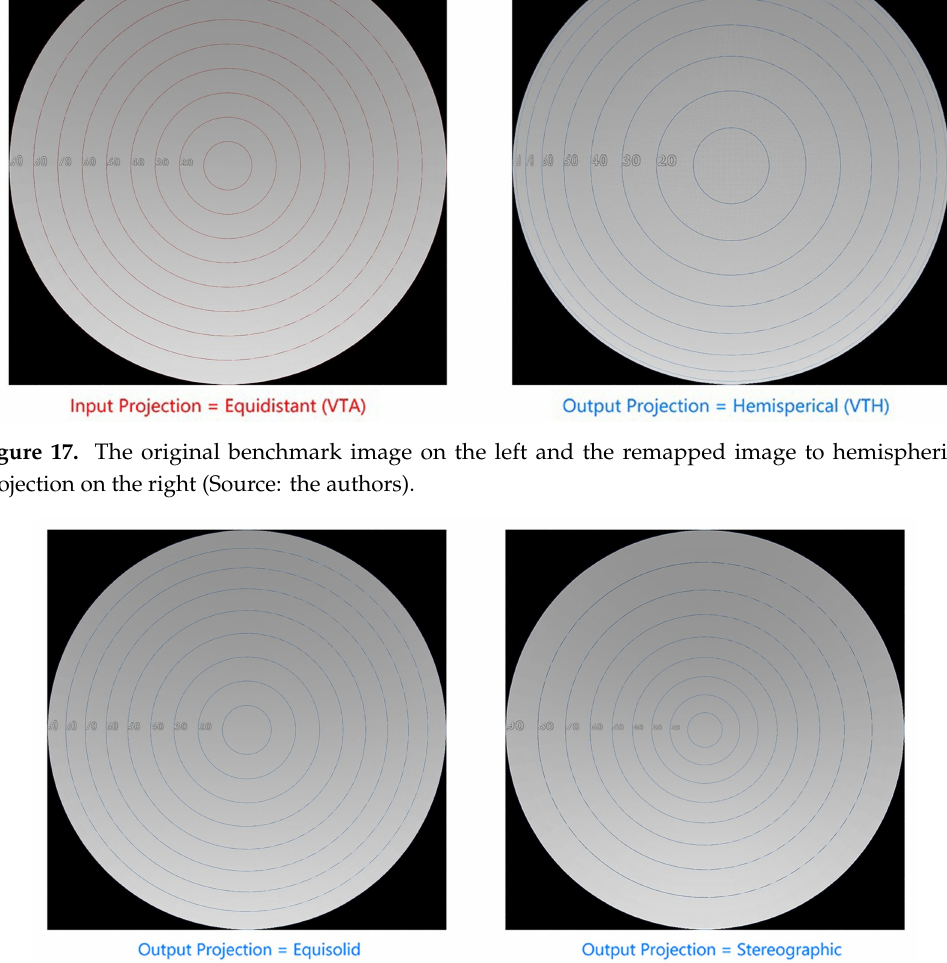
Figure 18. Shows the output fisheye images from the tool in equisolid and stereographic projection (Source: the